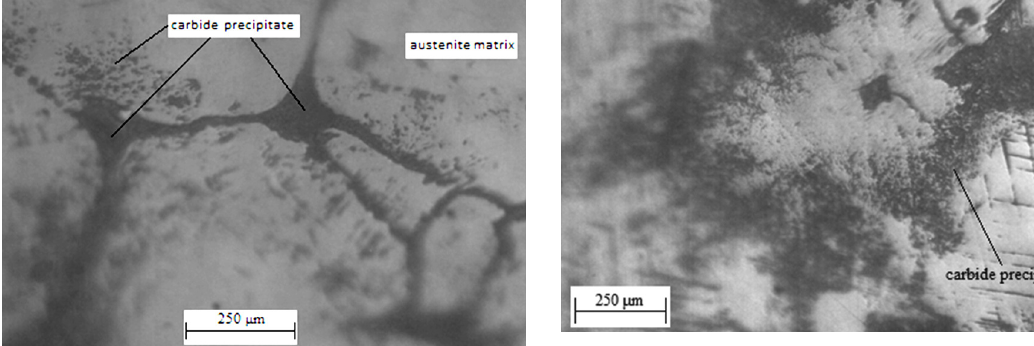
Figure 12. Optical micrograph of as-cast sample. The microstructure shows large carbides at austenite grain boundaries and in the grains of austenite matrix.